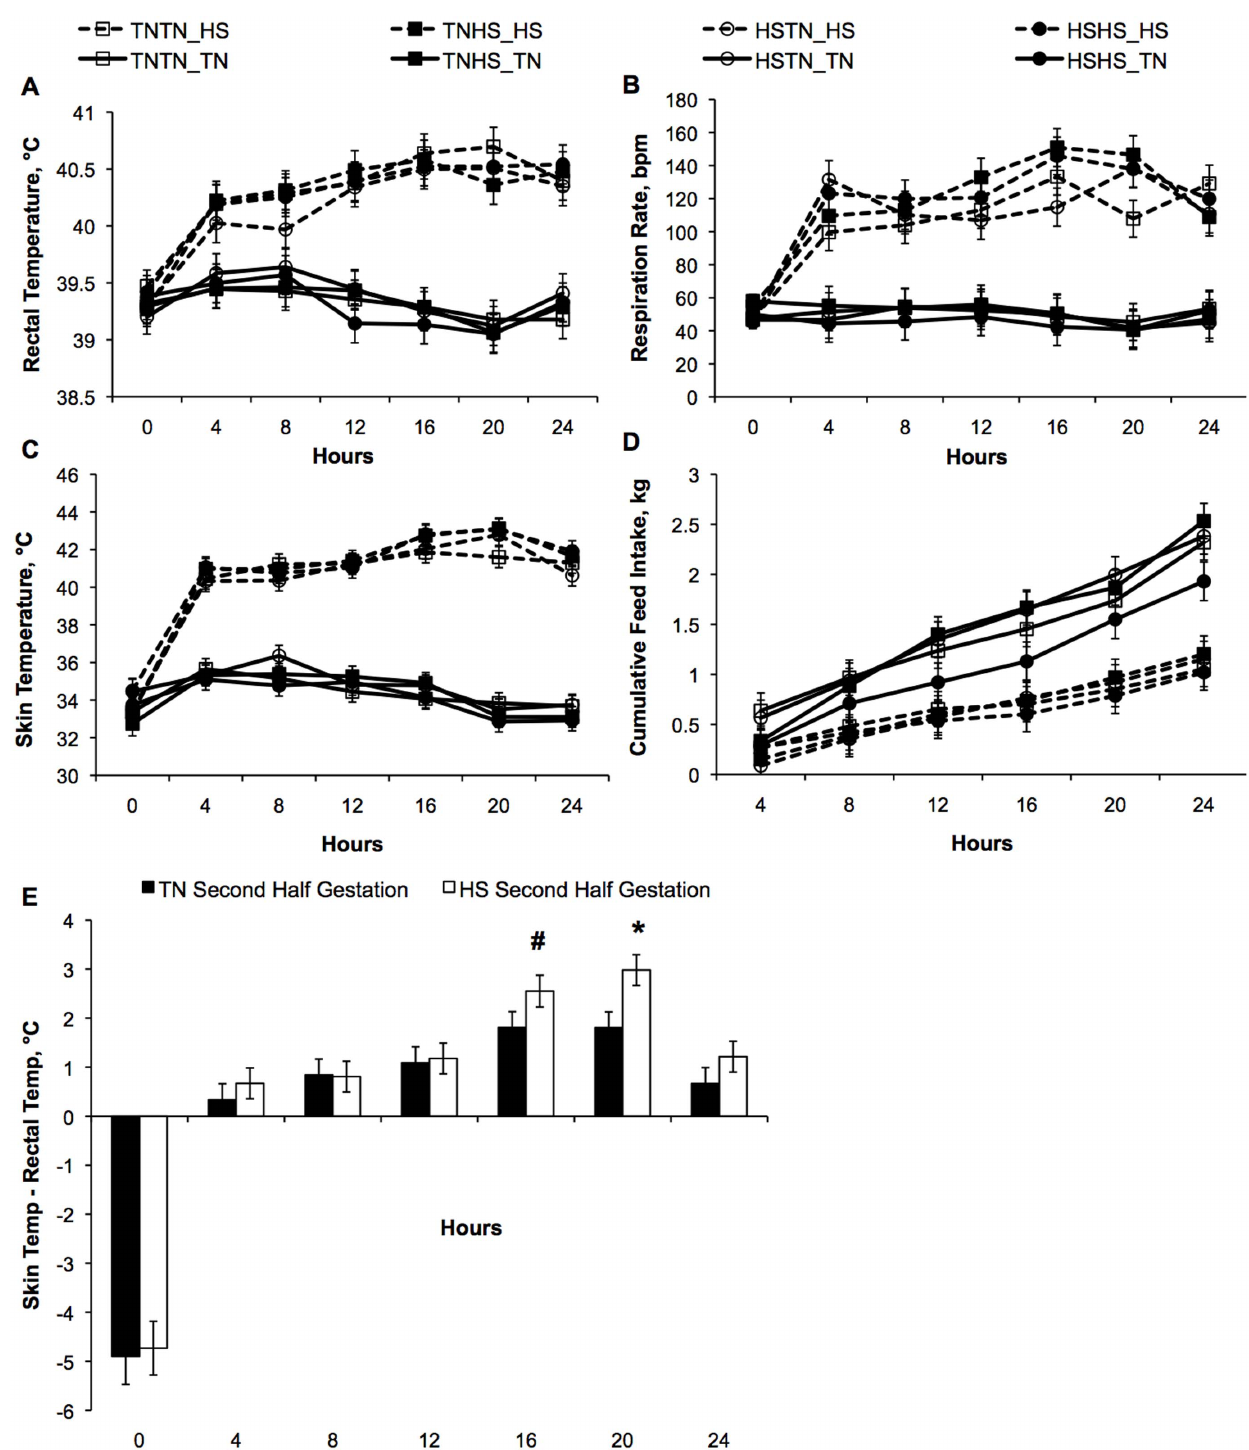
Figure 1. Acute postnatal heat stress (HS) alters temperature indices and feed intake over the 24 h treatment period. A) Rectal temperature increased during postnatal HS ( P , 0.001) and a postnatal treatment by time interaction was also detected ( P , 0.001). B) Respiration rate presented as breaths per minute (bpm) was elevated as a result of postnatal HS ( P , 0.001) in addition to the detection of a postnatal treatment by time interaction ( P , 0.01). C) Skin temperature was increased in pigs subject to postnatal HS compared to thermal neutral [30] counterparts ( P , 0.001) in addition to detection of a postnatal treatment by time interaction ( P , 0.001). A gestational by postnatal treatment interaction was observed in skin temperature ( P =0.05) whereby gestational treatments exposed to HS during the second half of gestation had higher skin temperature (0.5 u C) under HS conditions but lower skin temperature under TN conditions (0.3 u C) compared to HSTN and TNTN gestational treatments. D) Cumulative feed intake was reduced ( P , 0.01) in HS pigs compared to their TN counterparts. TN pigs gained weight while HS pigs lost weight over the acute HS period. No gestational effect was observed for feed intake or weight gain parameters ( P . 0.1). E) The difference between rectal and skin temperatures